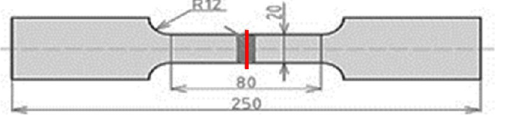
Figure 4. Test specimen for tensile test.